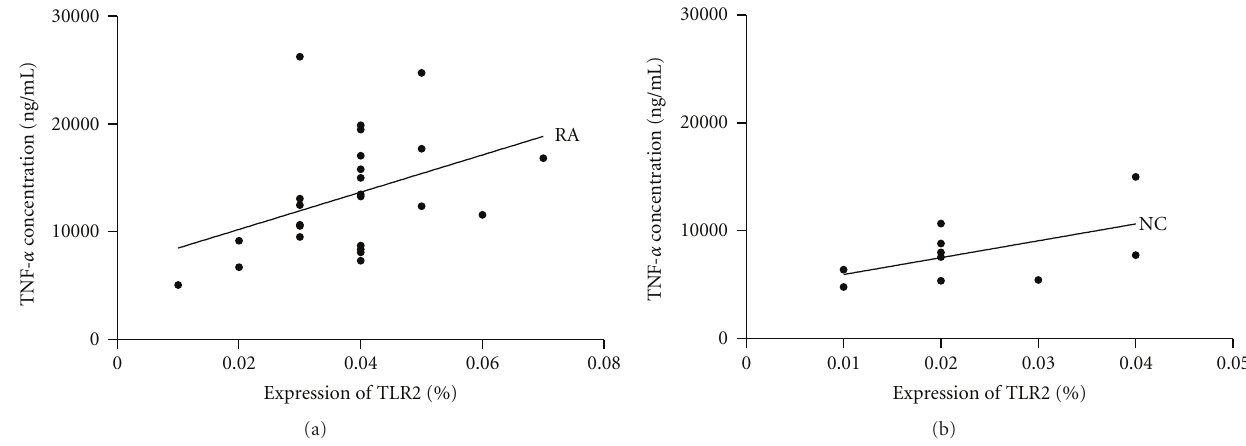
Figure 5: Relationship between TNF- α concentration and TLR2 expression (calculated as percentage of CD14 + monocytes expressing TLR2) in monocytes after stimulation with 10 μ g/mL of peptidoglycan in RA patients and normal controls (NC). (a) TLR2 expression significantly correlated with TNF- α concentration in RA patients ( r = 0 . 484, P = 0 . 014); (b) no significant correlation in normal controls ( r = 0 . 469, P = 0 .